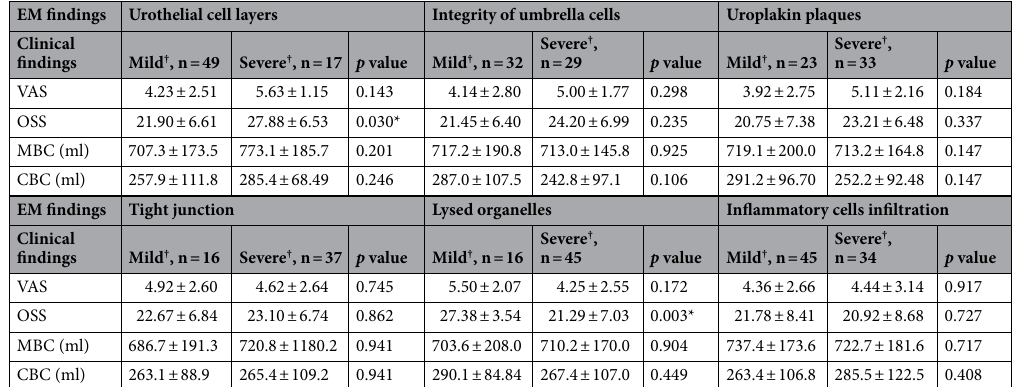
Table 3. Associations between IC/BPS symptom parameters and urothelial defect severity. EM Electron microscopic, IC/BPS Interstitial cystitis/bladder pain syndrome, VAS Visual analog score for pain, OSS score O’Leary-Sant Symptom score, MBC Maximal bladder capacity, CBC Cystometric bladder capacity. † Mild = Grade0, 1, 2; Severe = Grade 3. * p < 0.05 by independent samples t-test.